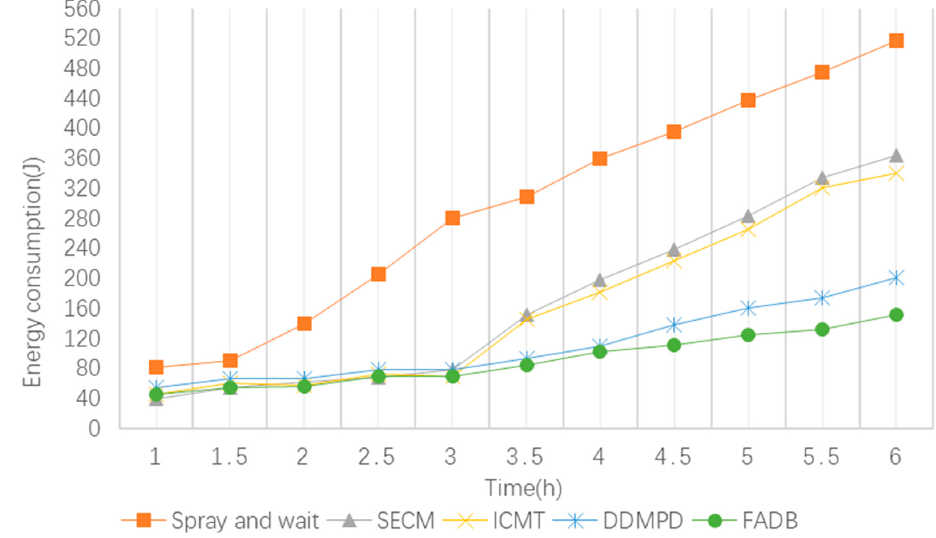
Figure 6. The relationship between energy consumption and time.